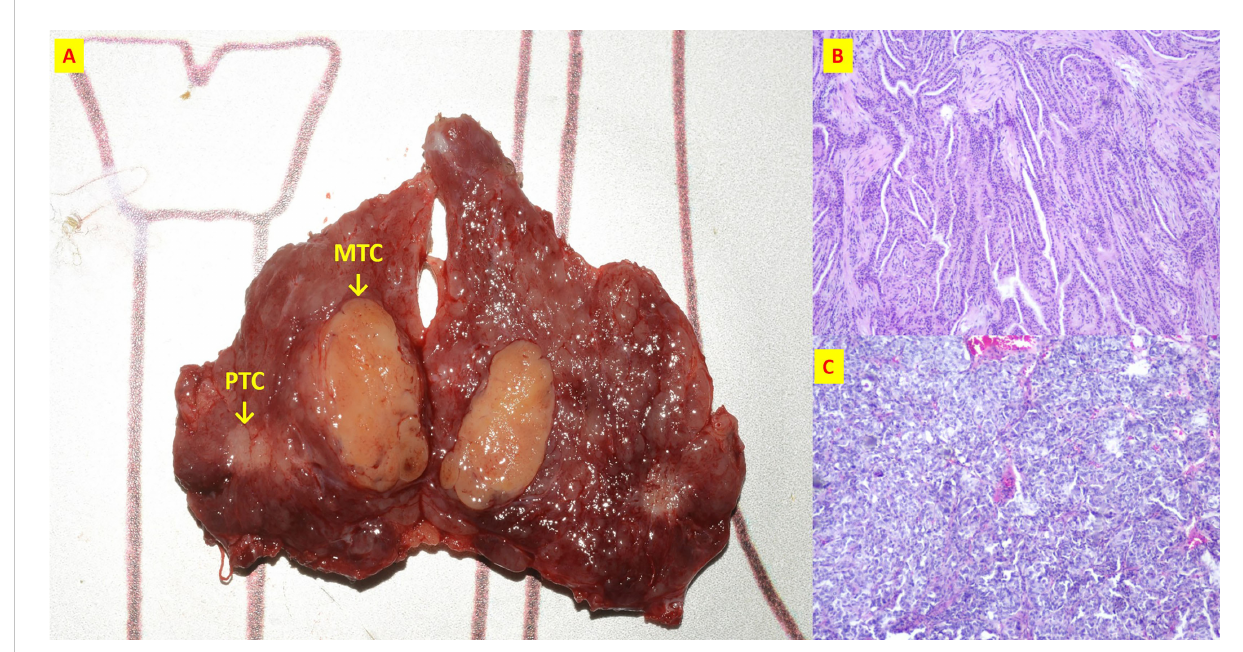
FIGURE 5 The patient n.17 that MTC and PTC were located in the different tumor of ipsilateral lobe. (A) Intraoperative resection of tumor pro fi le; (B) Histological sections of HE x40 of PTC; (C) Histological sections of HE x40 of MTC;.